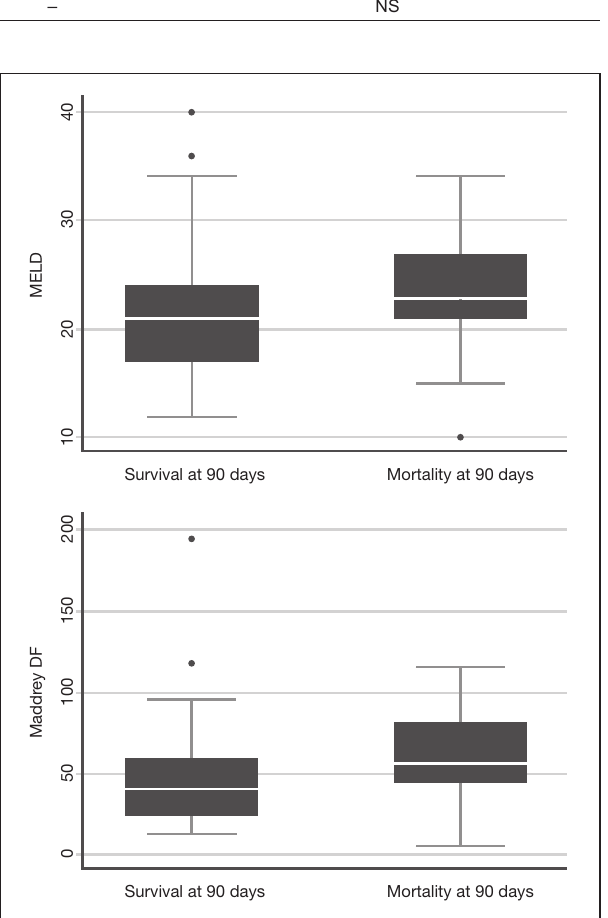
Figure 1) Distributions of the Model for End-stage Liver Disease (MELD) score and Maddrey discriminant function (DF) according to mortality at 90 days following hospitalization for alcoholic hepatitis. Patients who died within 90 days had higher MELD (P=0.04) and Maddrey DF (P=0.009) compared with survivors. The horizontal line inside each box represents the median, and the lower and upper borders of the box represent the 25th and 75th percentiles, respectively. Vertical lines from the ends of the boxes encompass the adjacent values. Outliers are denoted as closed circles